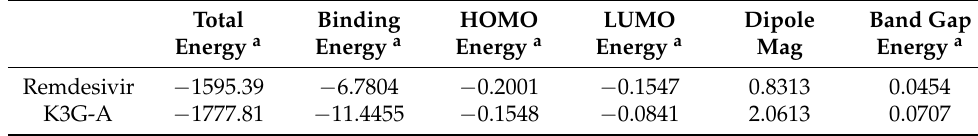
Figure 5. Spatial distribution remdesivir ( A ) and K3G-A ( B ). Table 3. Molecular orbital spatial distribution of remdesivir and